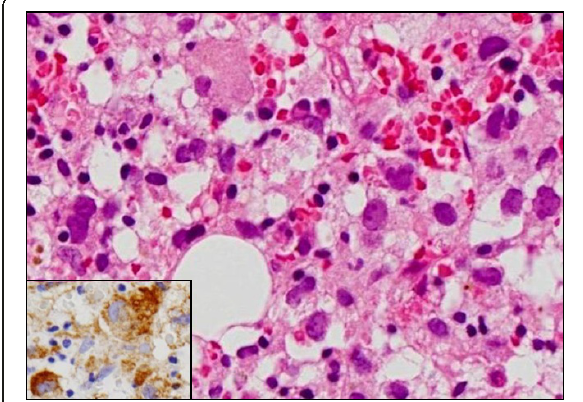
Figure 5 Histological and immunohistochemical examination of secondary bone marrow involvement of primary splenic HS. 2 months after the splenectomy, the tumor cells infiltrated the bone marrow tissue (H&E stains, Original magnification ×